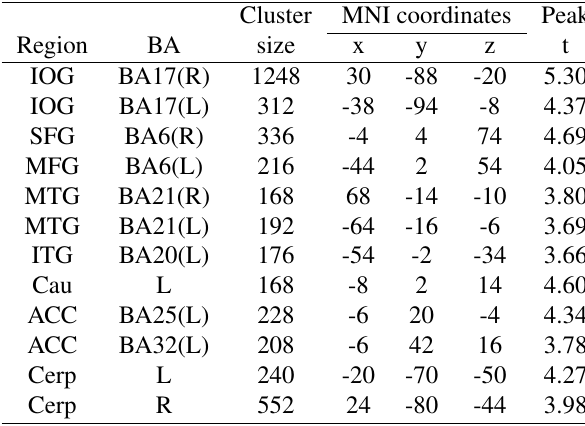
Table 2. Brain regions showing reduced connectivity in patients with early-onset schizophrenia relative to healthy controls